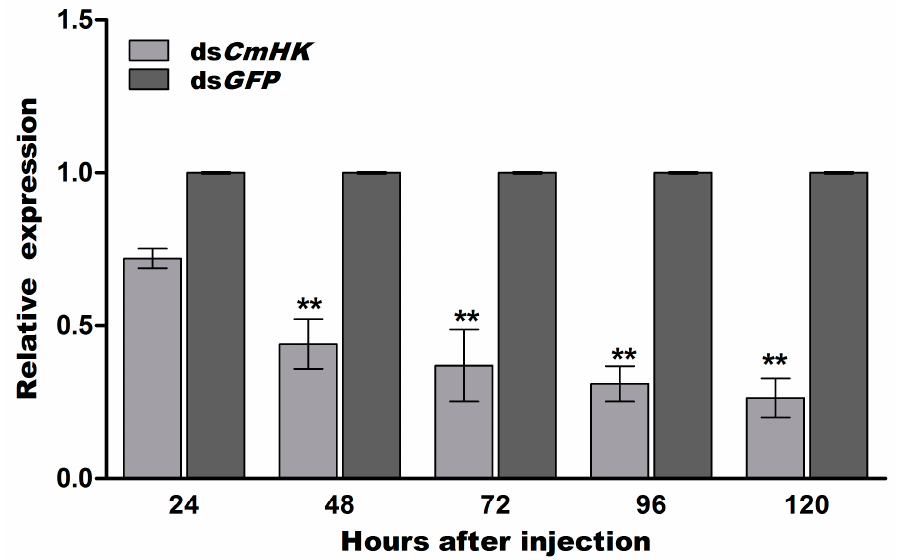
Figure 5. The expression level of CmHK after dsRNA treatment at 24-h intervals. Data were shown as the mean ± SD . Significant differences are indicated by ** ( P < 0.05).